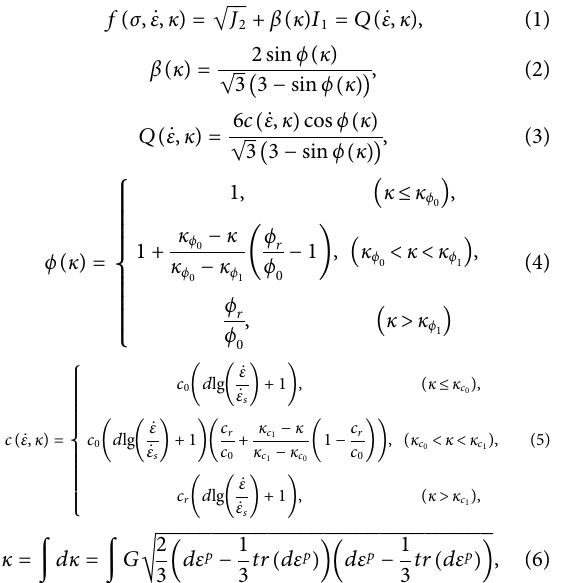
ϕ r represent the initial and residual internal friction angles;